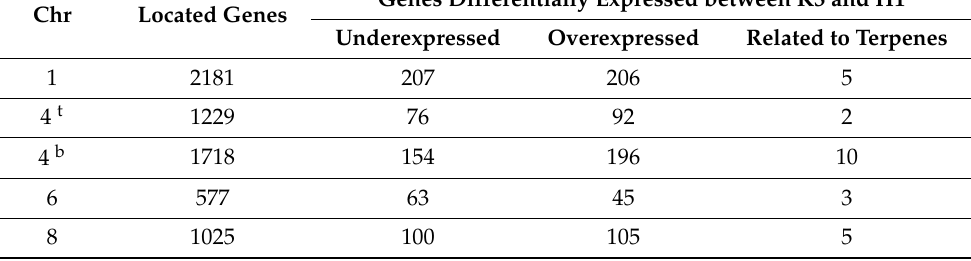
Table 2. Number of all genes and genes differentially expressed (GDE) identified by microarray analysis under mQTL-rQTL co-localization with special emphasis to the GDE potentially related to terpenes. t and b = top and bottom of chromosome (Chr) respectively. Genes Differentially Expressed between K3 and H1 Chr Located Genes Underexpressed Overexpressed Related to Terpenes